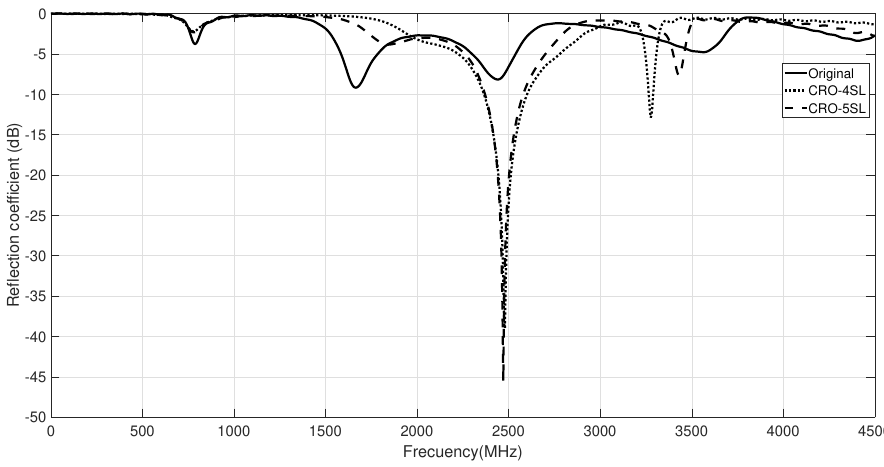
Figure 7. Reflection coefficients after the optimization process with the CRO-4SL and CRO-5SL.